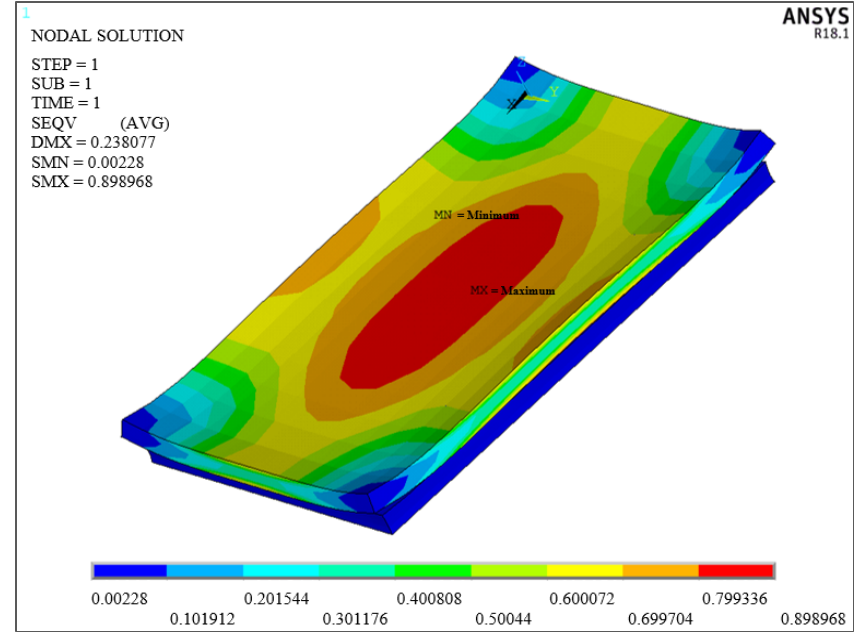
Figure 3. Maximum stresses induced by a negative gradient (ANSYS R18.1).